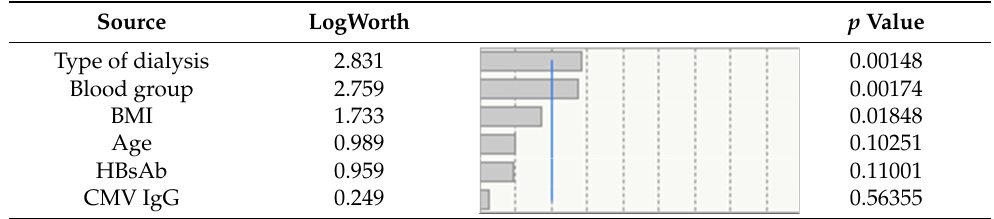
Table 3. Multiple regression for PRA